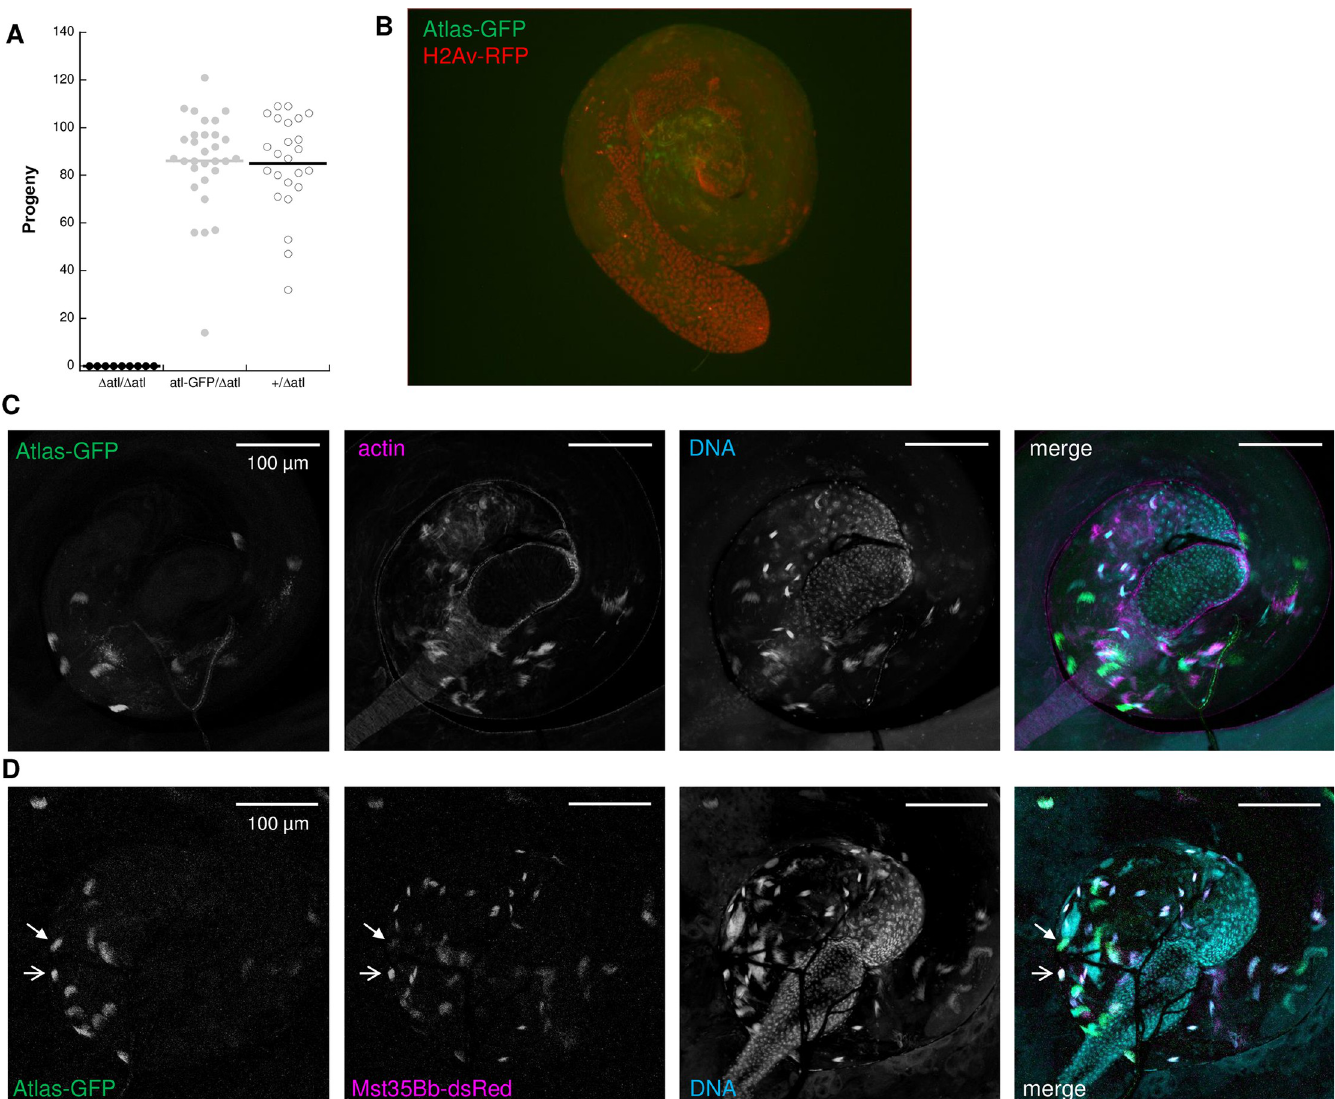
Fig 5. An atlas -GFP allele generated at the endogenous atlas locus is fully functional for male fertility and encodes a protein that localizes to condensing spermatid nuclei. A) A single copy of the atlas- GFP allele is sufficient for full fertility when paired with the Δ atlas allele, as compared to males heterozygous for the wild-type atlas allele ( Δ atlas / atlas -GFPfertility: 86.0 ± 3.2; Δ atlas /+ fertility: 84.9 ± 4.1; two-sample t-test assuming unequal variances, p = 0.85). B) Atlas-GFP does not co-localize with histone H2Av-RFP, a marker of the initial stages of spermatid nuclear condensation. C) Visualization of Atlas-GFP in the basal portion of whole-mount testes from atlas-GFP homozygotes shows that the fusion protein co-localizes with a subset of condensing spermatid nuclear bundles. While actin associates with fully condensed nuclei at the basal testis, Atlas-GFP does not overlap and is also absent from the seminal vesicle. D) Atlas-GFP partially colocalizes with Mst35Bb-dsRed, a marker of the final stage of nuclear condensation, in the basal portion of whole-mount testes. Open arrow: example of co-localization. Filled arrowhead: example of Atlas-GFP that does not co-localize with Mst35Bb-dsRed. Collectively, these data suggest that atlas may serve as a transition protein involved in the final stages of nuclear condensation. The whole testes from which the basal portions are shown in panels C and D are shown in S7 Fig. males with the atlas locus genotype atlas- GFP/ Δ atlas had equivalent fertility to males of geno- type atlas+ / Δ atlas (Fig 5A). We then visualized Atlas-GFP fusion protein in whole-mount tes- tes in conjunction with phalloidin-stained actin (Figs 5C and S7). Atlas-GFP was absent from seminal vesicles, consistent with its absence from the proteome of mature D . melanogaster sperm [69,70]. Instead, Atlas-GFP colocalized with condensing nuclear bundles near the basal